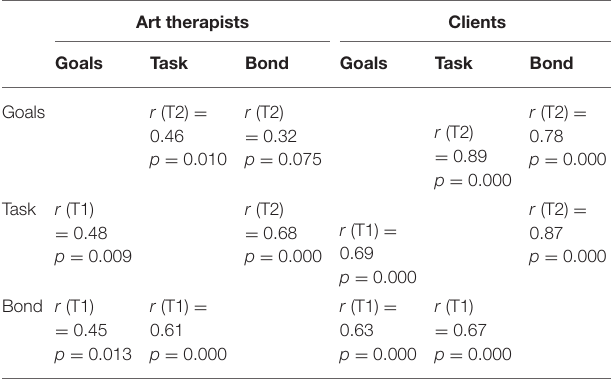
TABLE 2 | Pearson’s correlations between the therapeutic alliance sub-scales in art therapists and clients. Art therapists